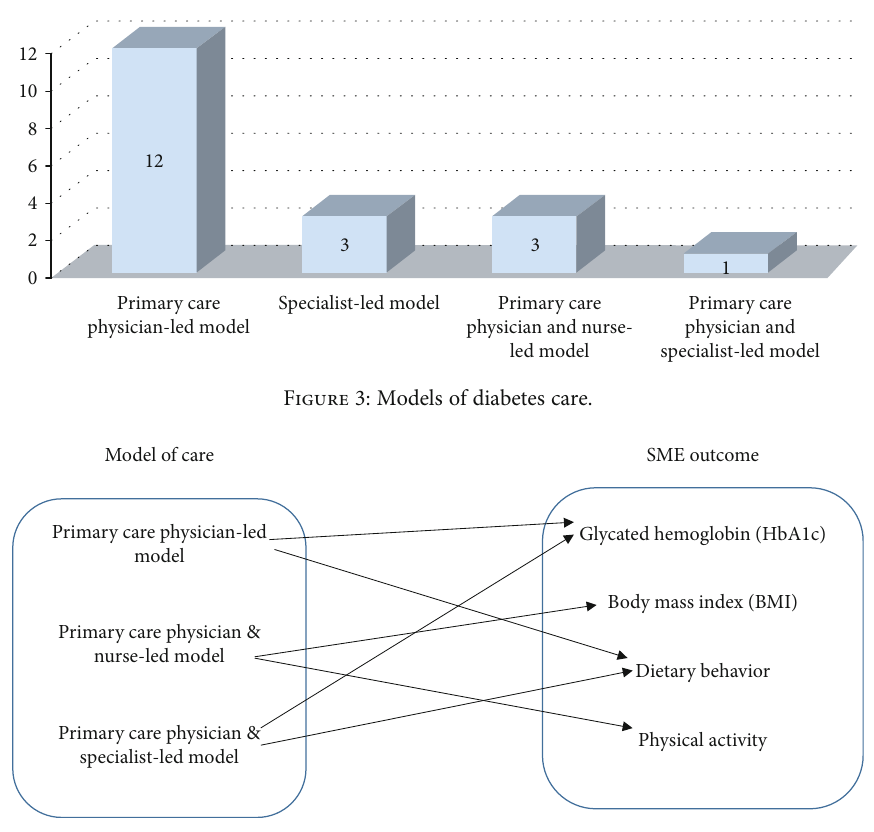
Figure 4: Comparison of positive SME outcomes by the di ff erent models of diabetes care. The arrow ( → ) indicates the positive e ff ect of a model of care on the SME outcome measures. The specialist-led model has been excluded because it had no positive e ff ect on the outcome